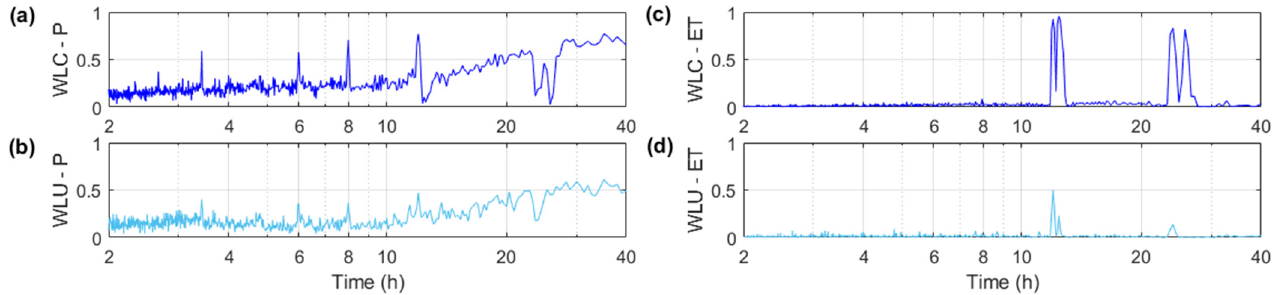
Figure 4. The coherence functions between the atmospheric pressure and the level of confined (WLC) ( a ) and weakly confined (WLU) ( b ) aquifers, ground displacement coherence function at WLC ( c ) and WLU ( d ) aquifers.